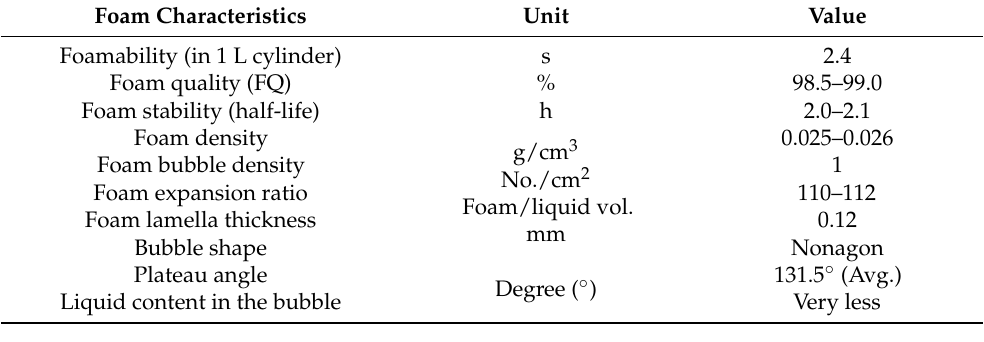
Table 2. Characteristics of surfactant foam generated via a foam sprinkling system.